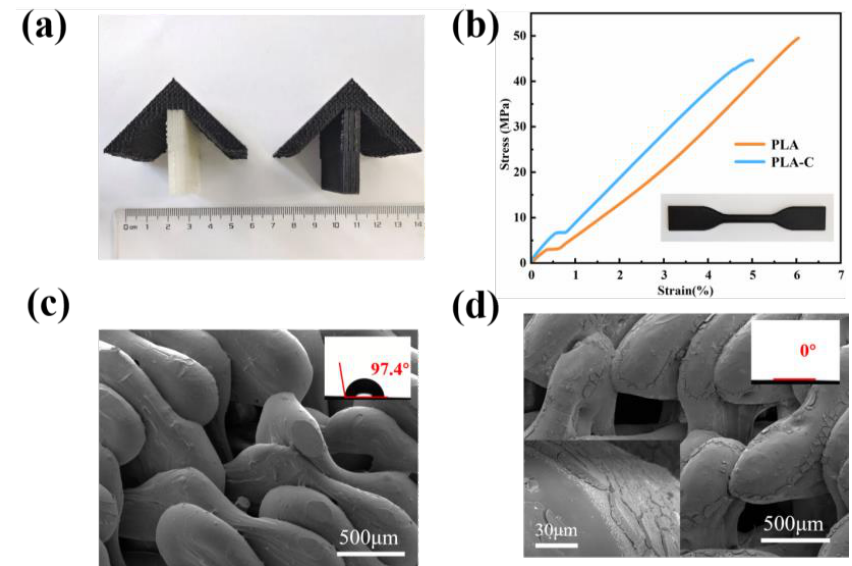
Figure 4. ( a ) digital photograph of the 3D-printed crystallizer structure without and with coating; ( b ) tensile properties of the standard tensile specimen; ( c ) Microstructure and wettability of crystallizer without PVP-TA-Fe 3+ coating; ( d ) Microstructure and wettability of crystallizer with PVP-TA-Fe 3+